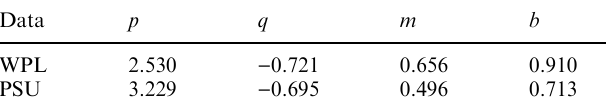
Table A3. Parameters of fitted log-normal distributions for the thickness H (km) of cirrus estimated from p and q Data